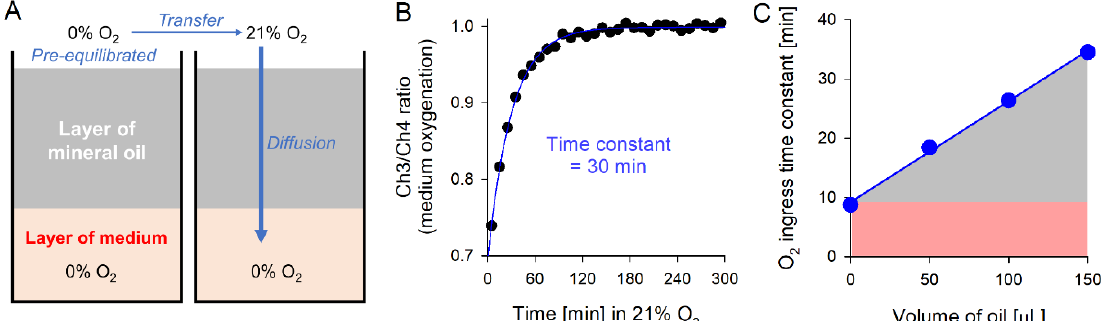
Figure 4. Characterizing the open system with respect to O 2 dynamics. ( A ) The protocol for measuring O 2 permeability across a layer of medium (typically 100 µ L) and oil (varied between 0 and 150 µ L). ( B ) Exemplar time course from well covered with 150 µ L oil. Transferring a plate to an atmosphere of normal oxygen in the reader triggers re-oxygenation, which was monitored every 10 min. The best fit gives a time constant, which is inversely related to O 2 permeability. ( C ) Relationship between the time constant of O 2 ingress and the volume of oil added to wells. Red shading denotes time constant attributable to medium, and gray denotes that due to diffusion through oil.